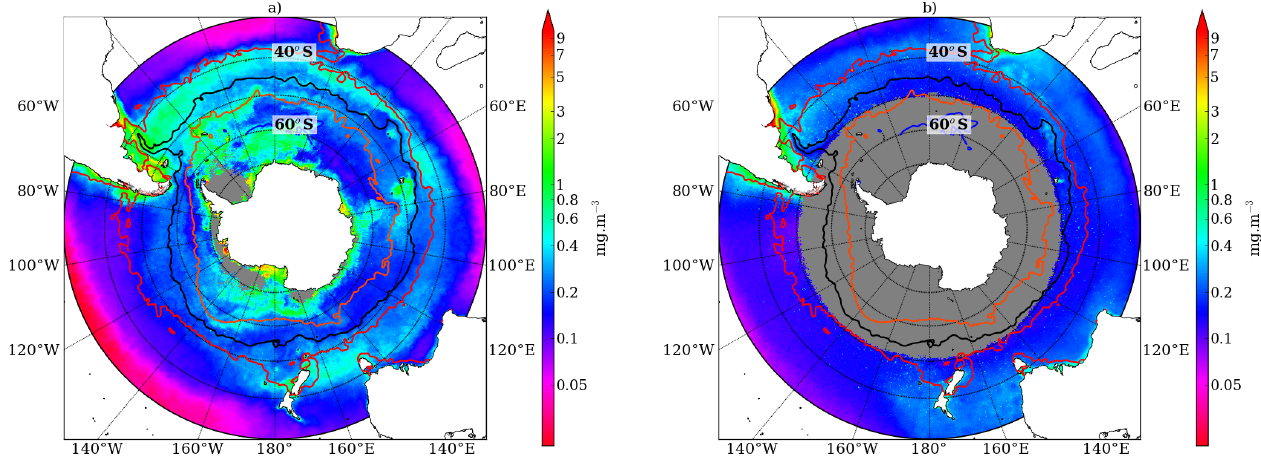
Fig. 1. Spatial distribution of mean chlorophyll concentrations for the Southern Ocean south of 30 ◦ S for (a) summer–January and (b) winter– July. Mean July and mean January (1998–2007) frontal positions calculated from MADT contours are shown for the STF (red), the SAF (black), the PF (orange) and the SACCF